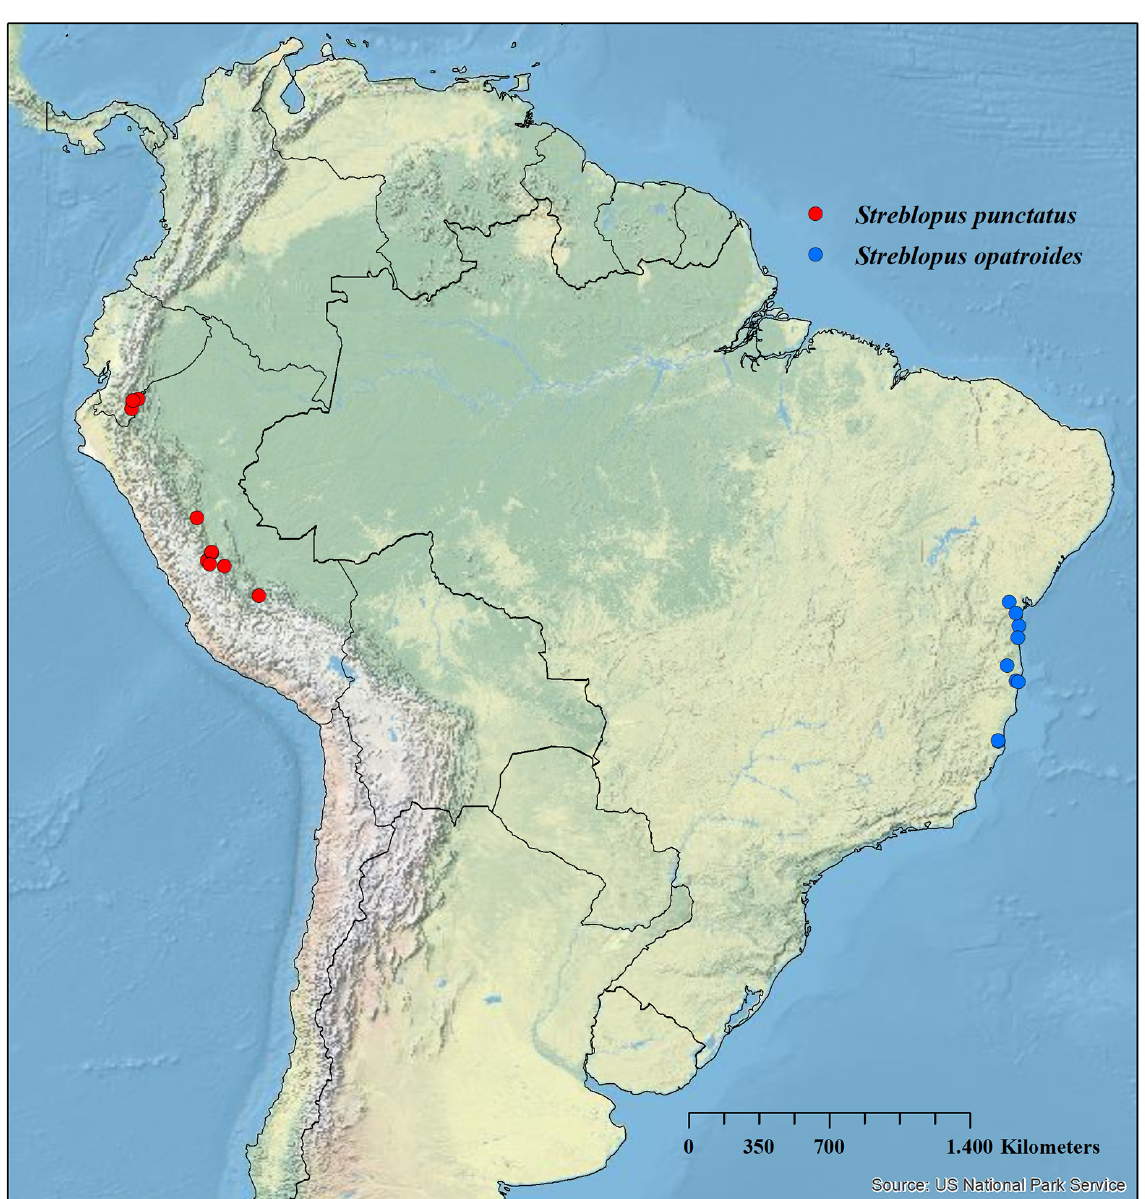
Fig. 4. Distribution of Streblopus van Lansberge, 1874. Note how the two species are widely separated by the vast South American Dry Diagonal stretching between Amazonia and the Atlantic Forest. During several different times over the Neogene, forest corridors connected the two biomes and the populations of Streblopus could move from one to the other. When the forest retreated, the distribution of the genus became